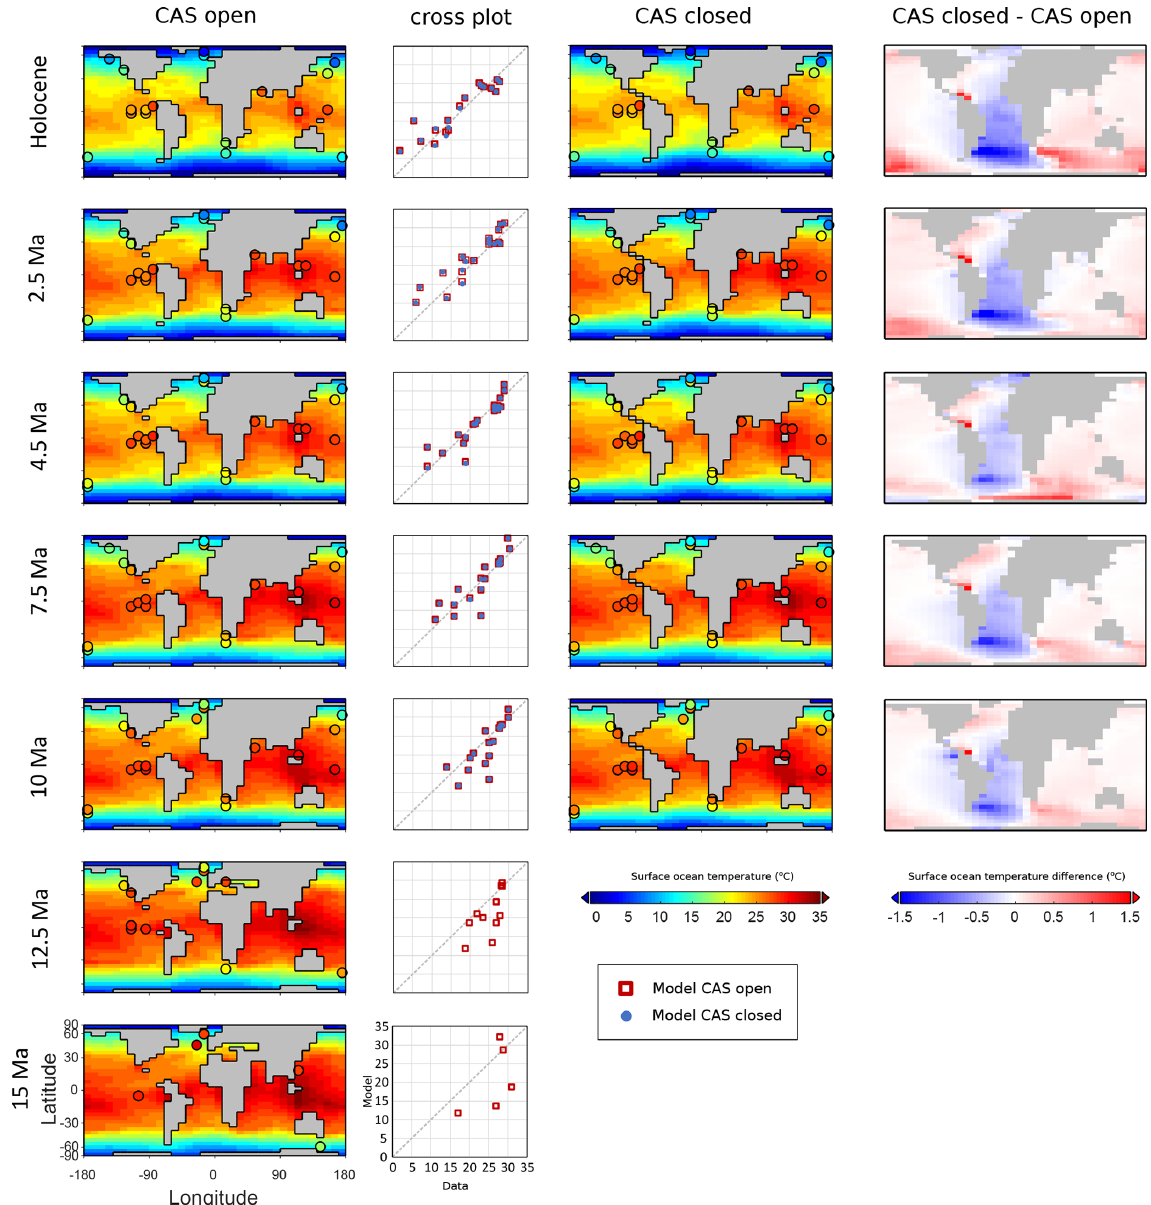
Figure 9. Modelled and data-indicated surface ocean temperatures for the best fit model settings, with data overlaid as shaded circles (temperature maps), and cross plots of data points ( x axis) and model points ( y axis) for both CAS cases. The surface temperature difference is shown on the right. The model–data fit statistic (M-score) is shown in Fig.